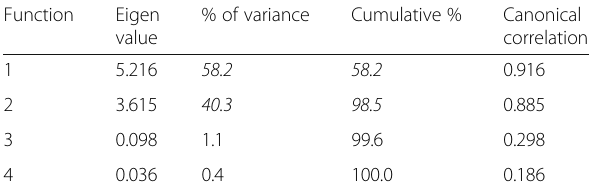
Table 3 Relative power of discriminant functions. The first two functions are the most important and account for about 98.5% of the total variation Function Eigen Cumulative % Canonical value